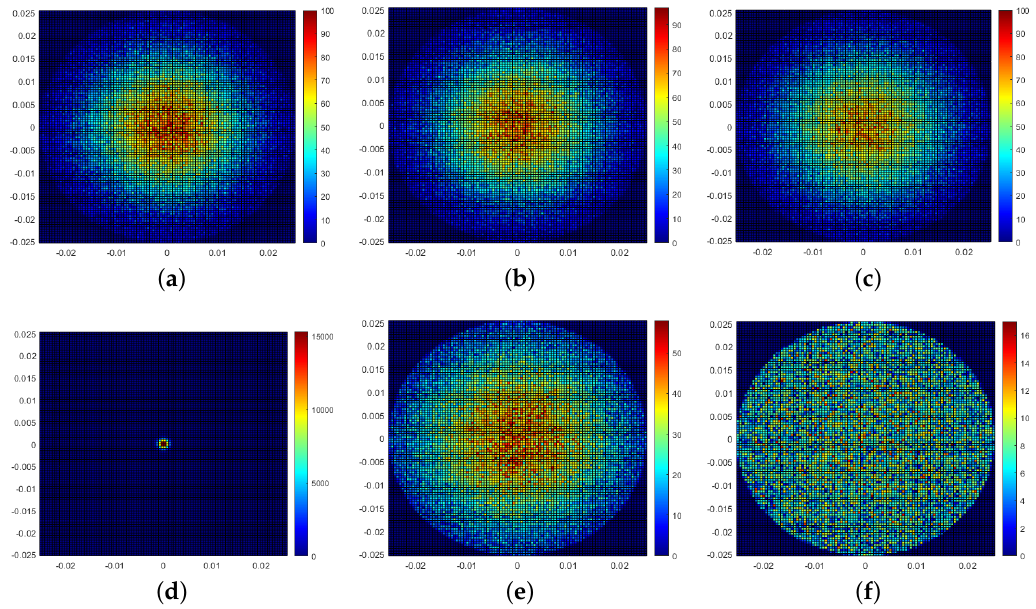
Figure 5. Intensity distributions of the light with a beam width of ( a ) 1 mm, ( b ) 2 mm, ( c ) 3 mm at the reception plane after transmitting through a 10 m clear ocean water. Intensity distributions of the light with a maximum beam divergence angle of ( d ) 0 mrad, ( e ) 2 mrad, ( f ) 5 mrad at the reception plane after transmitting through a 10 m clear ocean